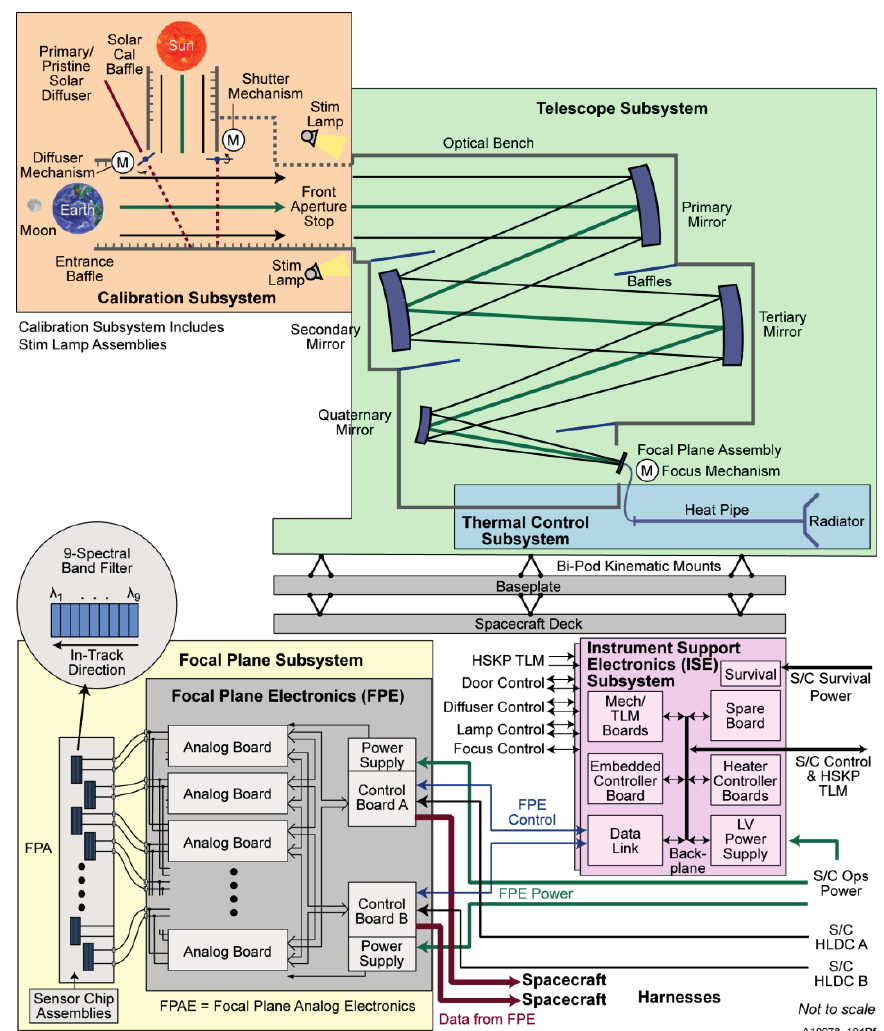
Figure 3. OLI block diagram. Light enters the aperture from either the Earth or one of many calibration sources, passes through the telescope to the focal plane array, where it is digitized and the signal transmitted to the